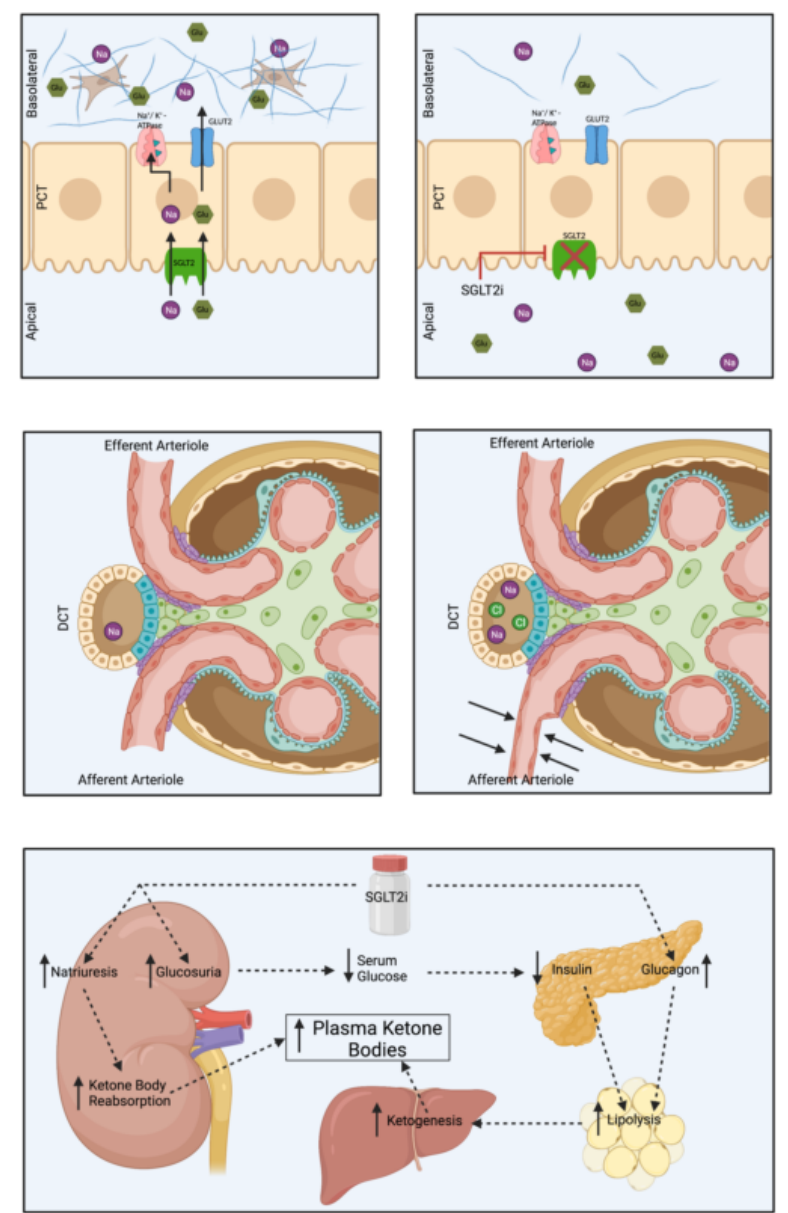
Figure 3. Visual representation of the mechanism of action of sodium glucose transport protein 2 (SGLT2) inhibitors. Top: Under normal circumstances (left), sodium and glucose are both reabsorbed proximal convoluted tubule (PCT) through the sodium–potassium exchanger, while glucose utilizes GLUT2 to exit the PCT cell. The presence of excessive glucose on the basolateral side of the PCT cell results in increased extracellular matrix production and fibrosis. Inhibiting SGLT2 will result in decreased sodium and glucose in the interstitial space (right), resulting in decreased extracellular